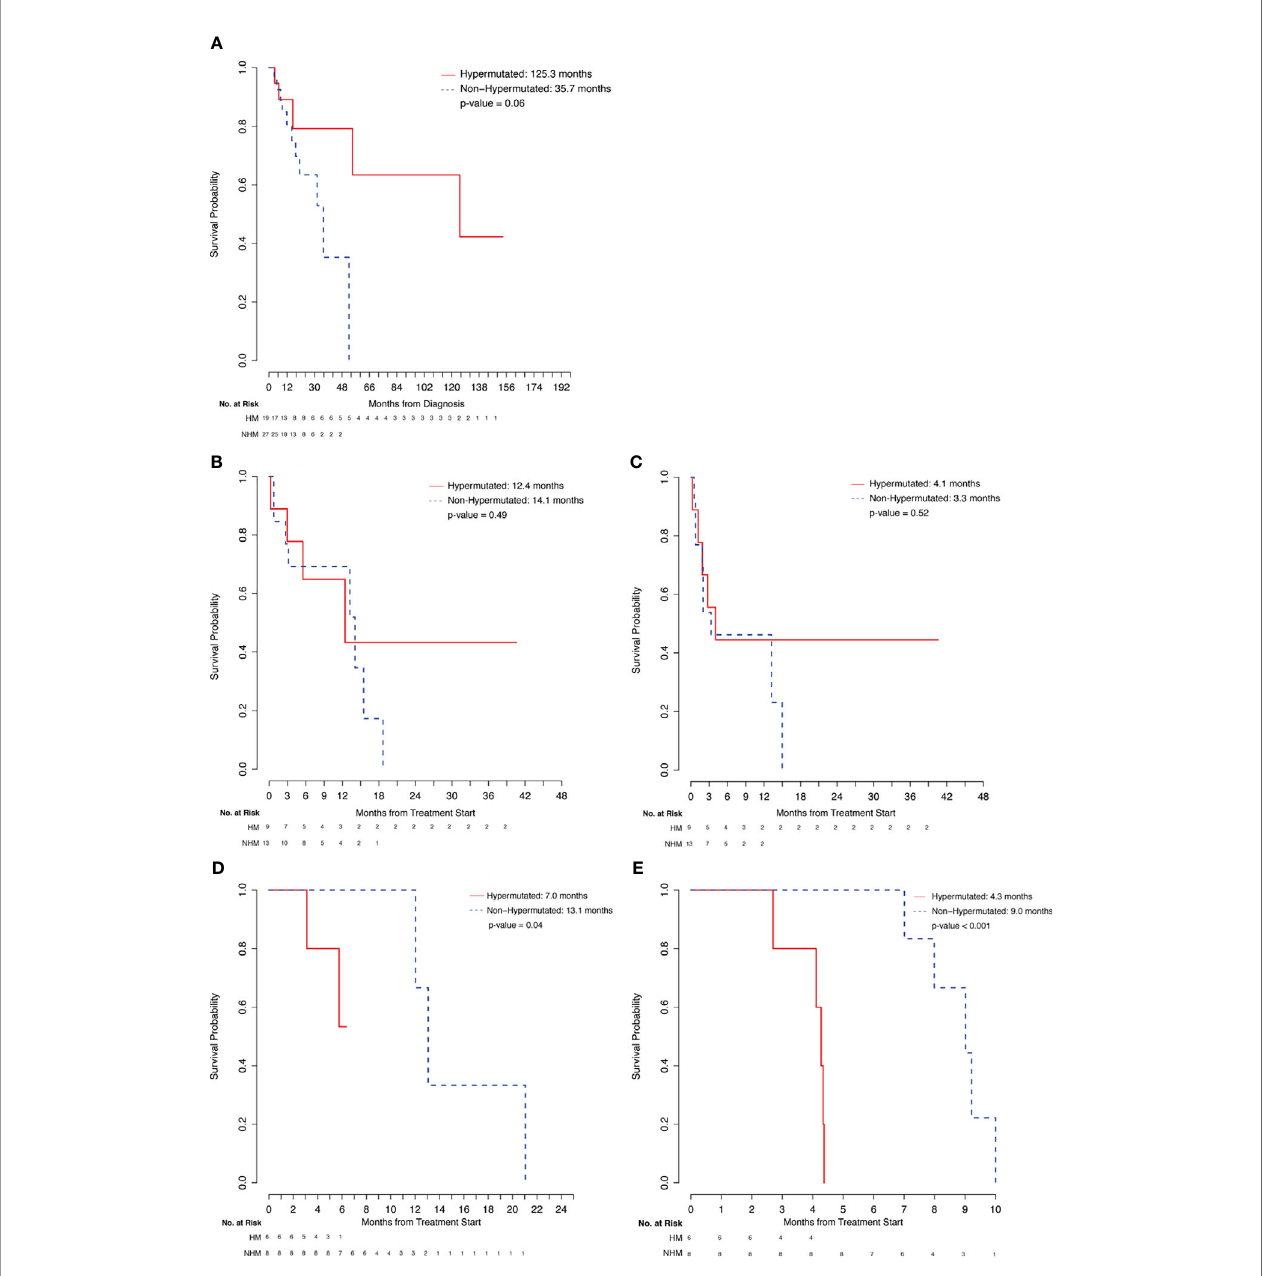
FIGURE 2 | Comparison of hypermutated patients. (A) Overall Survival from Diagnosis. (B) Overall Survival from Immunotheraphy Start. (C) Progression-Free Survival from Immunotherapy Start. (D) Overall survival from Chemotherapy Start. (E) Progression-Free Survival from Chemotherapy